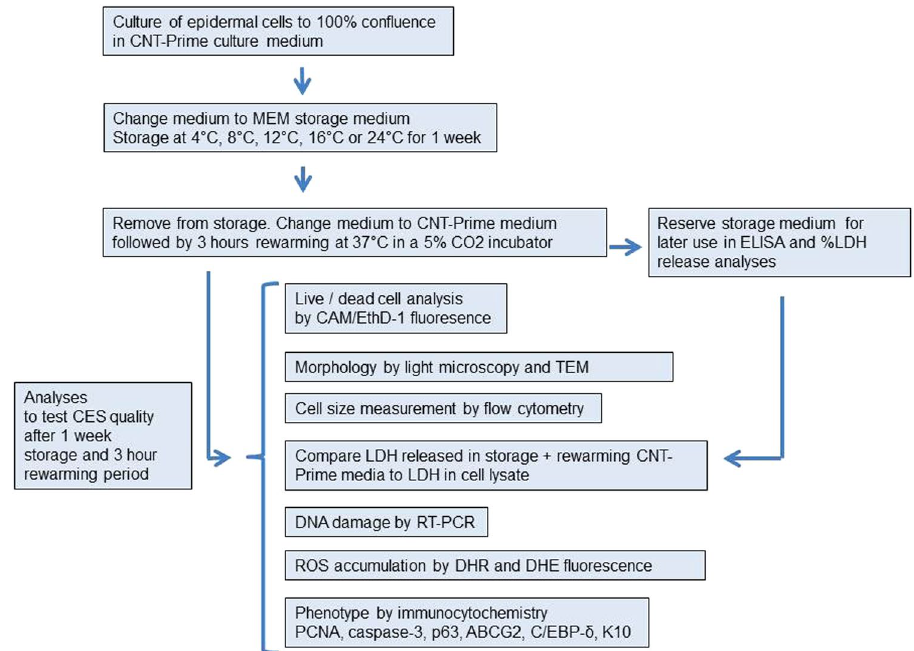
Figure 1. Workflow of culture, storage and quality-testing